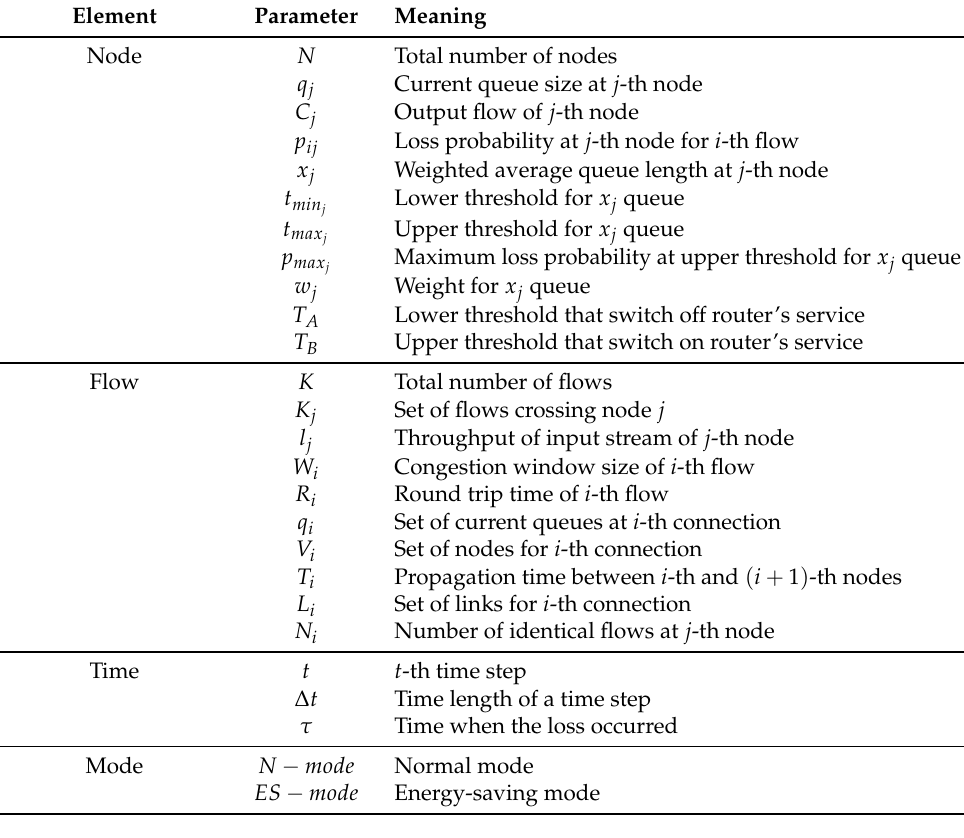
Table 1. Notations used in the